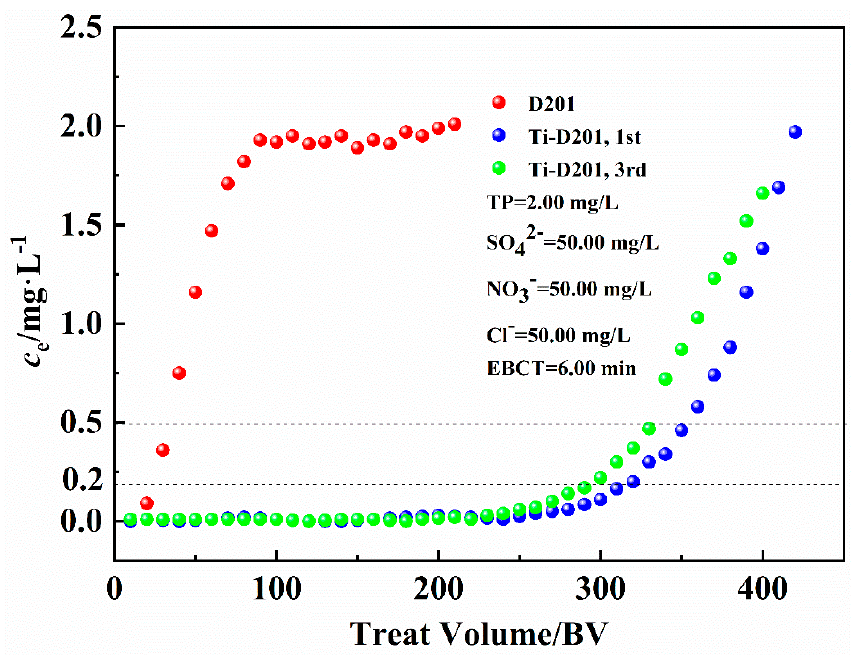
Figure 8. Column adsorption curve.